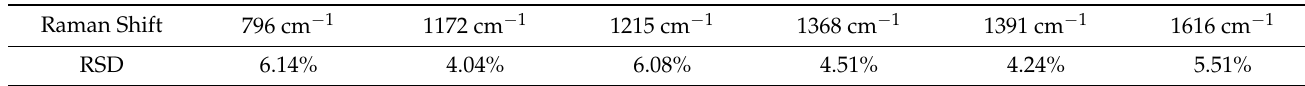
Table 1. The RSD value of MG molecules’ Raman peaks from 16 Raman spectra obtained on the hydrophobic SERS